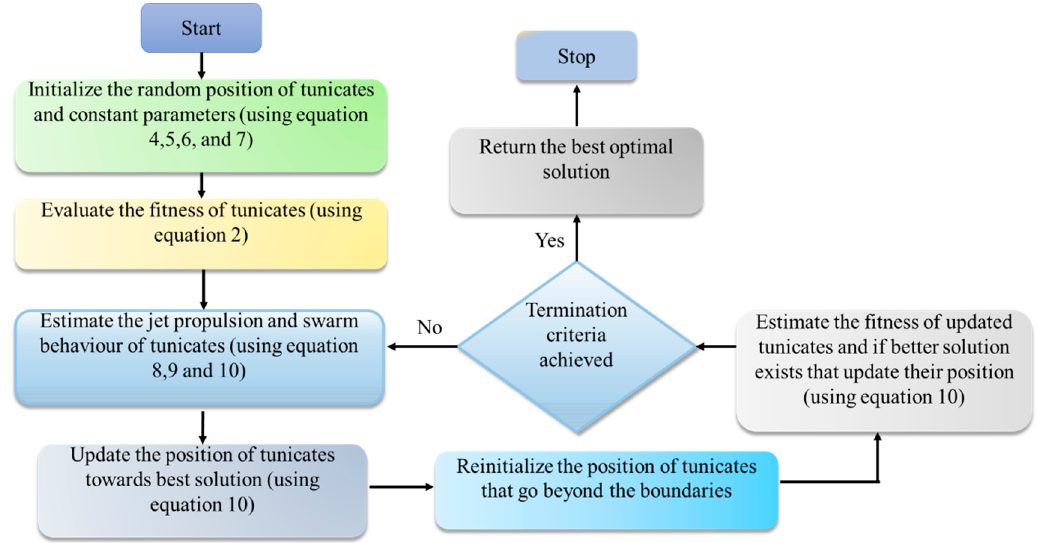
Figure 2. Process flow diagram of the Tunicate swarm algorithm (TSA).